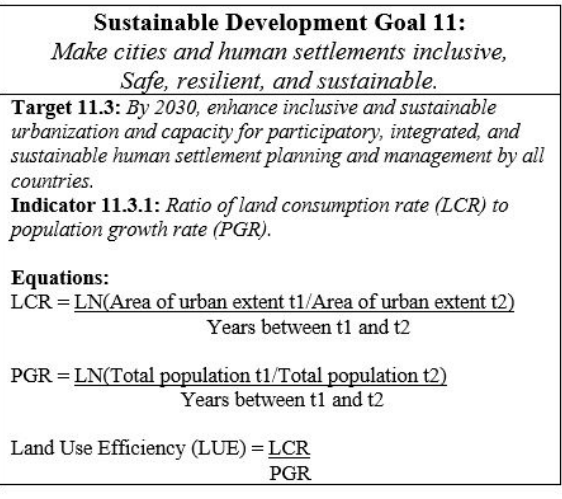
Figure 1. UN Sustainable Development Goal 11.